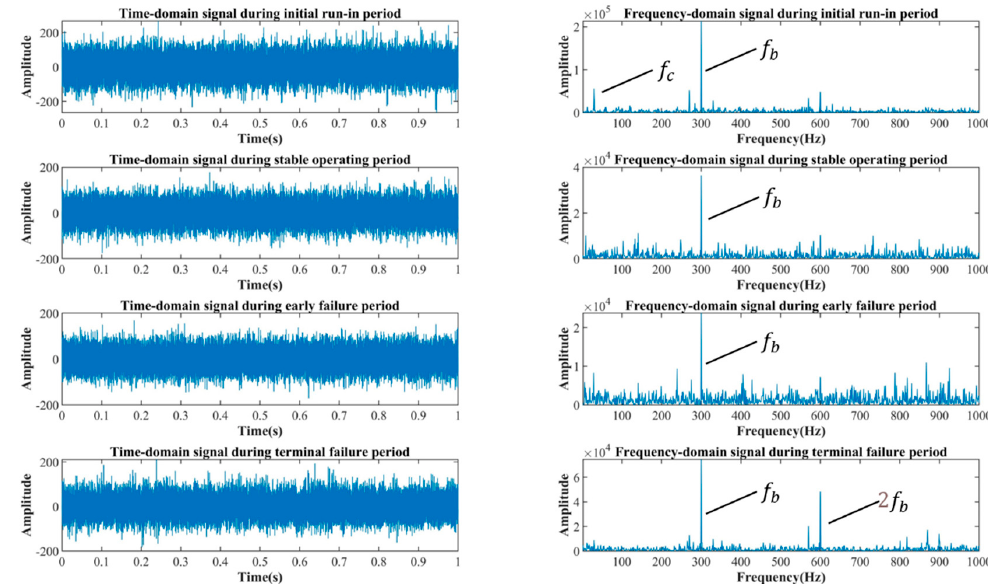
Figure 7. Internal gear pump signals in the four operating periods after CAE